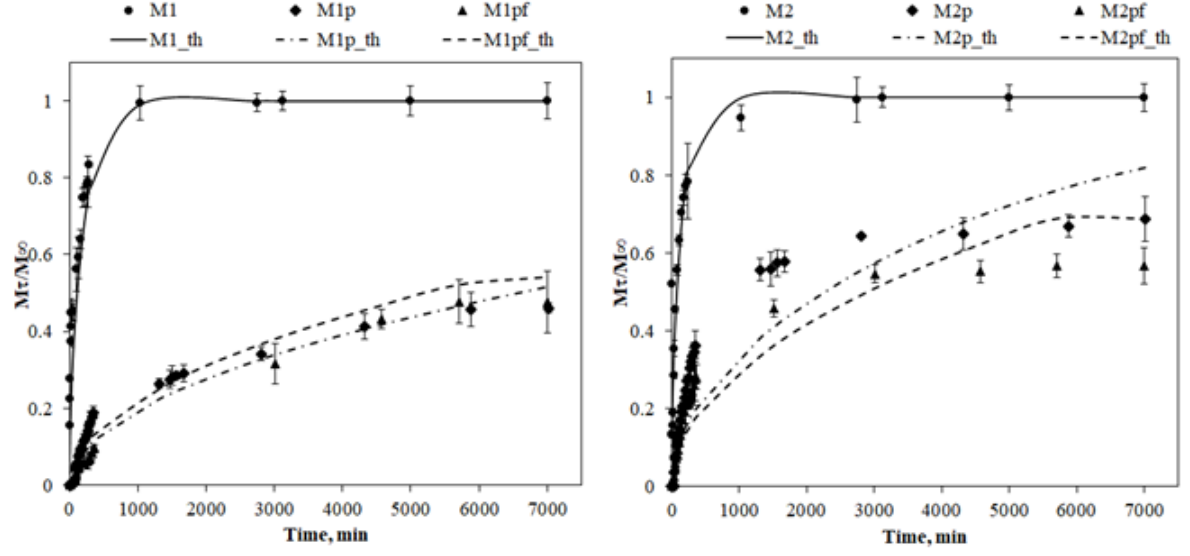
Figure 2. TC-HCl release profiles from mono- and multilayer membranes: experimental (points) and theoretical using Fick’s diffusion equation (continuous lines for monolayer membranes, and dashed lines for multilayer